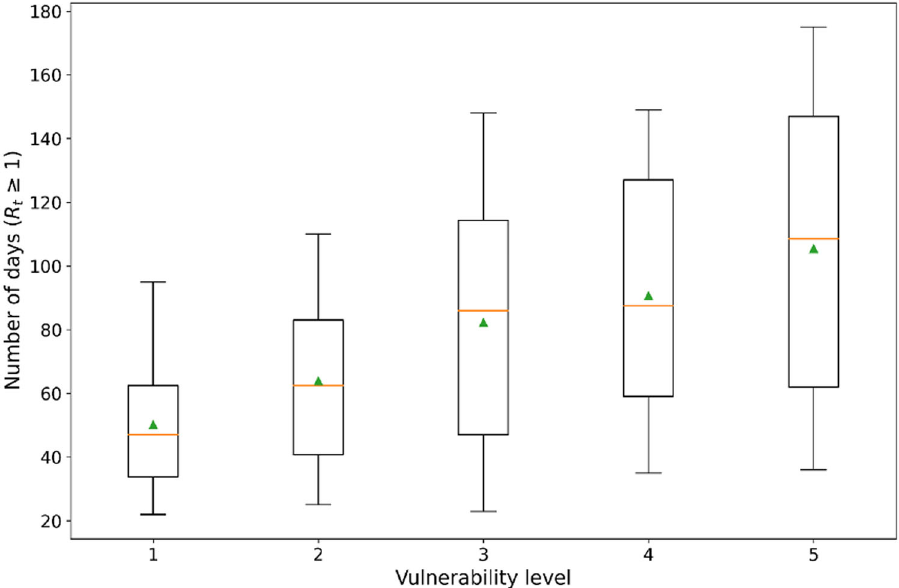
Fig. 3 Changes in the number of highly transmissible days with varying vulnerability levels. The solid brown line indicates the median value, and the green triangle indicates the mean value.